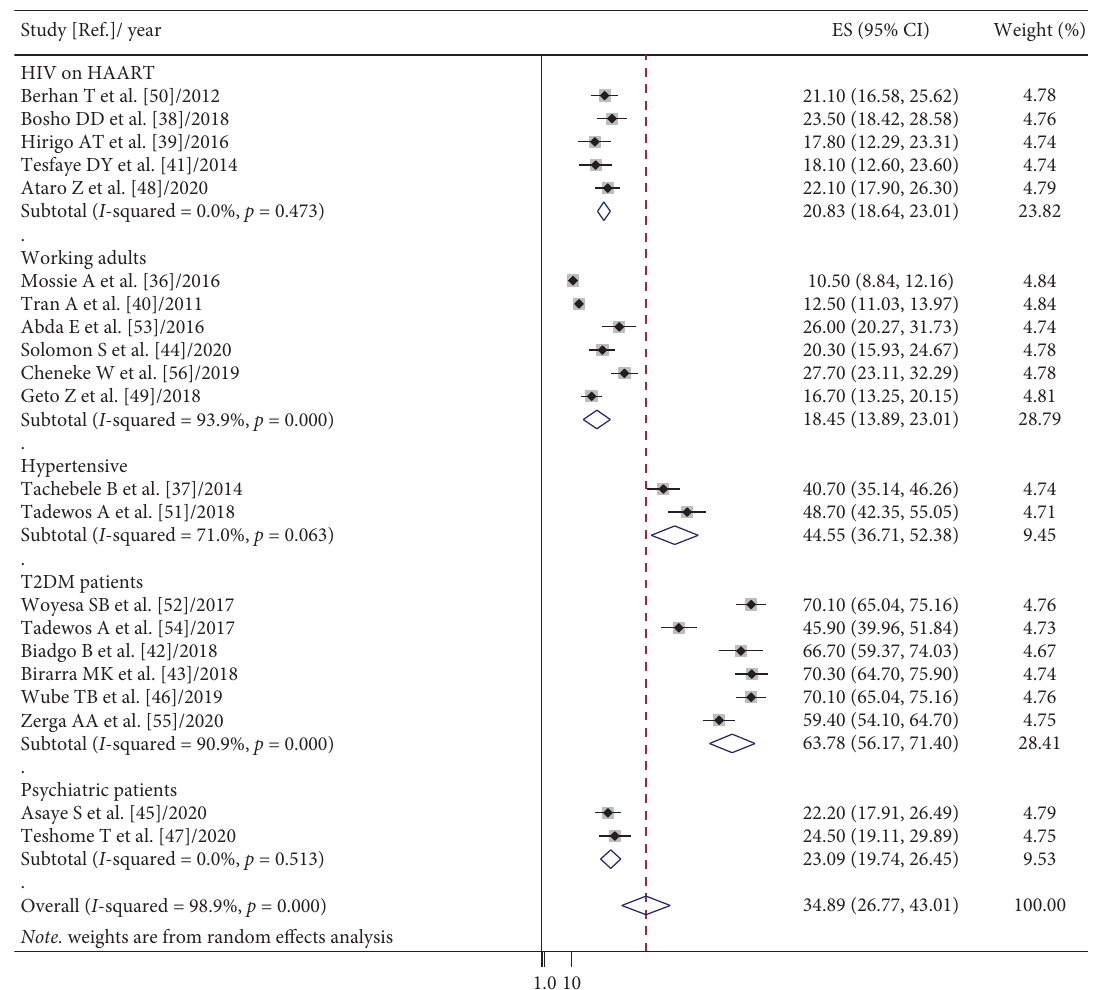
Figure 2: Forest plot of metabolic syndrome prevalence in Ethiopia based on NCEP/ATP III